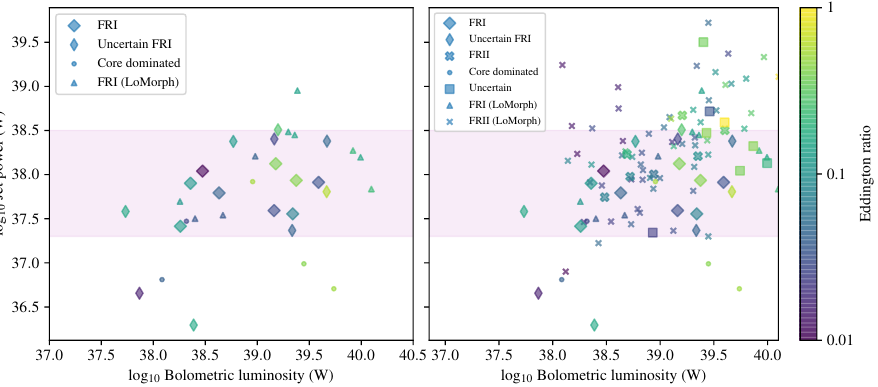
Figure 6. The distribution of total bulk kinetic power as function of radiative power of our target sources: FRI, uncertain FRI, core-dominated quasars, respectively. We also show FRI quasars clas- sified by LoMorph left ) [11]. The right panel shows the same distribution as the right-hand side but we further include quasars with uncertain morphological classification as well as LoMorph- FRII quasars. For a clean representation, we show FRII quasars and uncertain FRIIs using the same symbol. Pink shaded regions just highlight the narrow range of jet powers of FRIs across a wider range of their radiative powers. Colour coding shows the Eddington ratios (i.e., Bolometric luminosity/Eddington